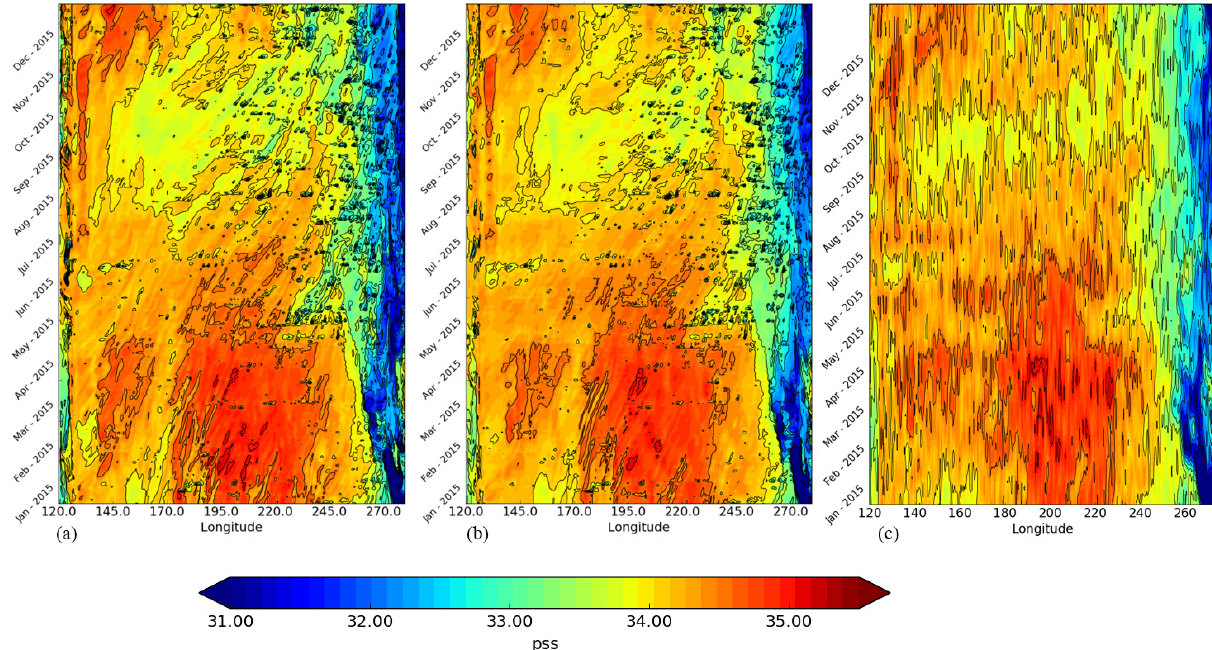
Figure 11. Hovmöller diagram of SSS at 5 ◦ N for the REF (a) and SMOSexp (b) and SMOS data (c) .